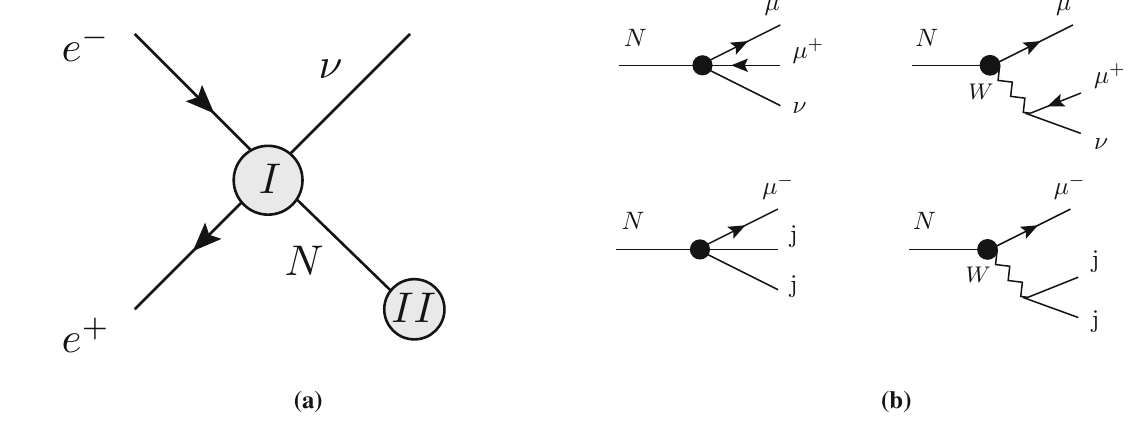
Fig. 1 Single N production and decay in the di-muon channel and di-jet channels